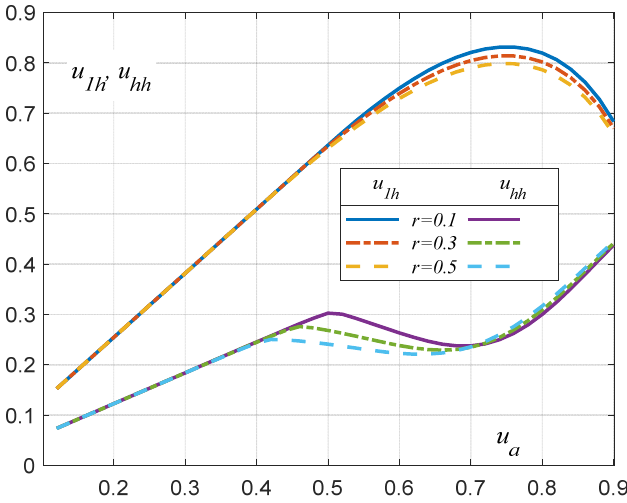
Figure 7. Amplitudes of the first harmonic and higher harmonics of the load voltage as a function of load voltage amplitude and resistance.